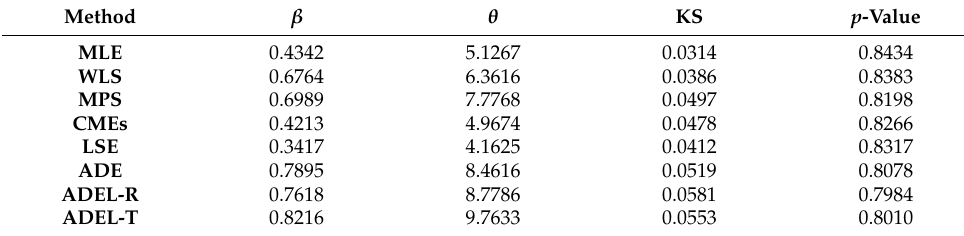
Table 7. Different parameter estimators for cancer patients’ data.